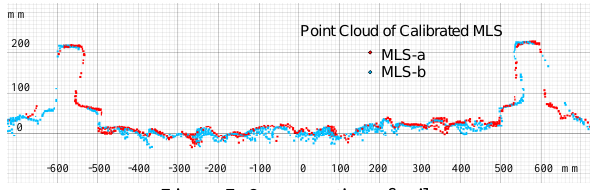
Figure 7. Cross section of rails